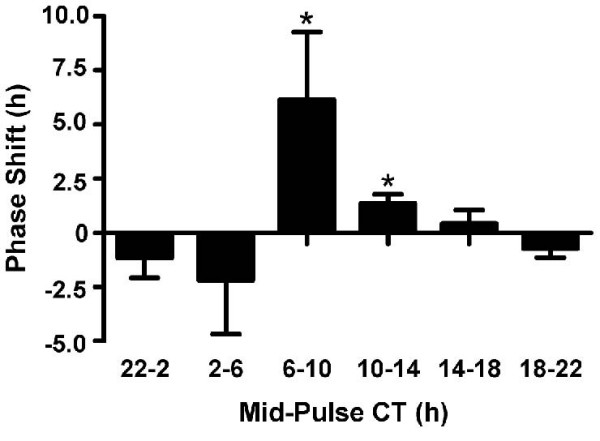
Phase-response curve to 6 h dark pulses of mouse wheel-running rhythms. Histograms represent mean ± 95% CI. Significant advances were elicited by dark pulses centered between CT6-10 and CT10-14, while pulses centered on the late subjective night/early subjective day had inconsistent resetting actions.